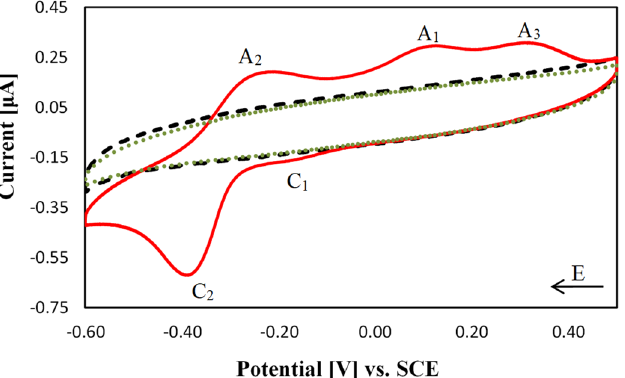
Figure 4. Typical cyclic voltammograms registered at the DNA biosensor in 0.1 M PB, pH 7.0 (black dashed trace), in 20 μ M of [Cu(TPMA)(bipy)] 2+ (red solid trace) and after washing [Cu(TPMA)(bipy)] 2+ from the DNA layer for 1 h (green dotted trace). Scan rates, 100 mV s − 1 .